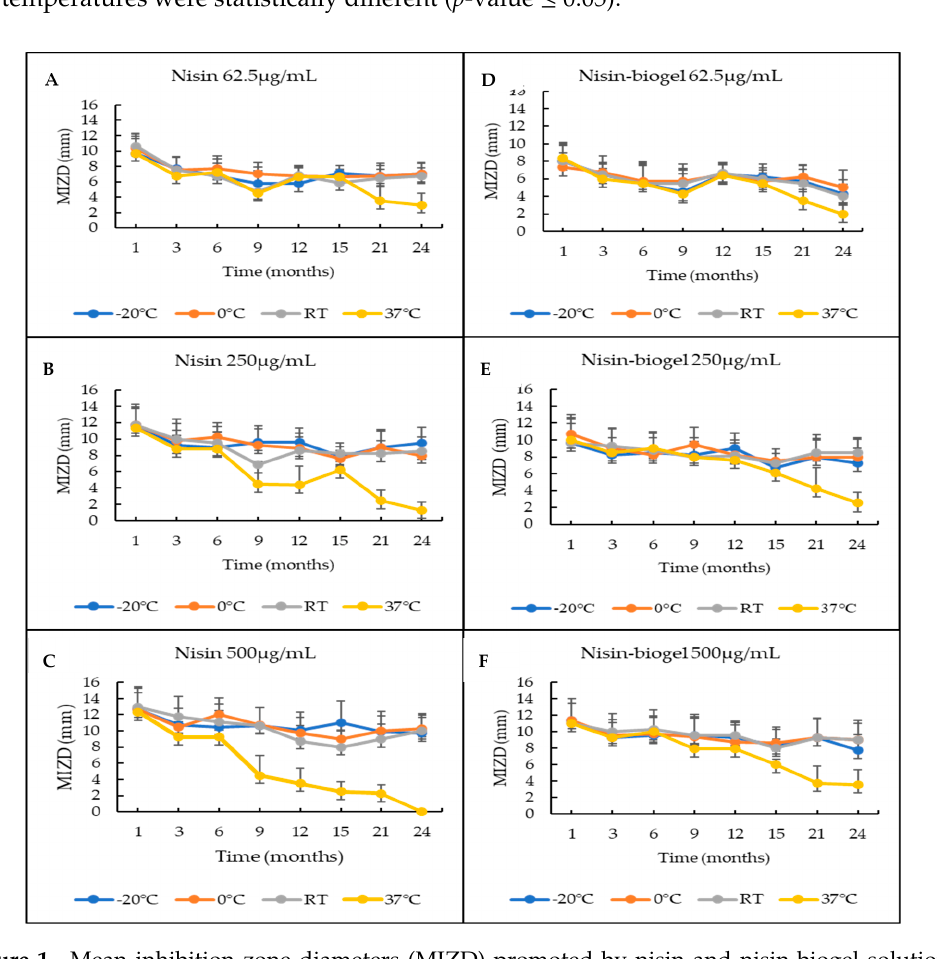
Figure 1. Mean inhibition zone diameters (MIZD) promoted by nisin and nisin-biogel solutions, over a 24 month period at four storage conditions (–20 ◦ C, 0–4 ◦ C, RT-room temperature and 37 ◦ C). The vertical bars represent the standard error of the mean. ( A )-MIZD promoted by nisin at 62.5 µ g / mL; ( B )-MIZD promoted by nisin at 250 µ g / mL; ( C )-MIZD promoted by nisin at 500 µ g / mL; ( D )-MIZD promoted by nisin-biogel at 62.5 µ g / mL; ( E )-MIZD promoted by nisin-biogel at 250 µ g / mL; ( F )-MIZD promoted by nisin-biogel at 500 µ g /